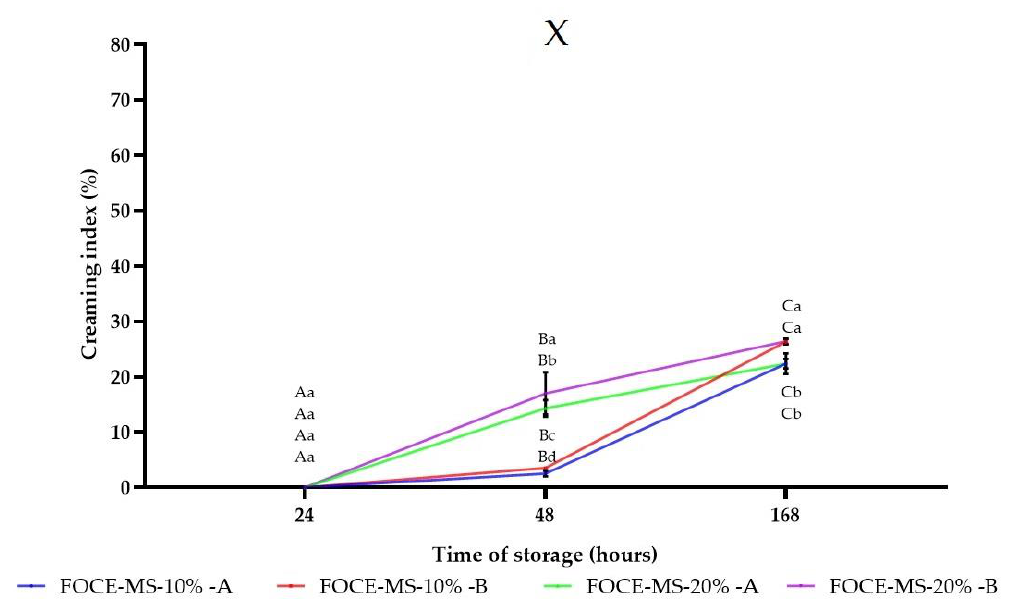
Means with different lowercase are significantly different at p < 0.05.